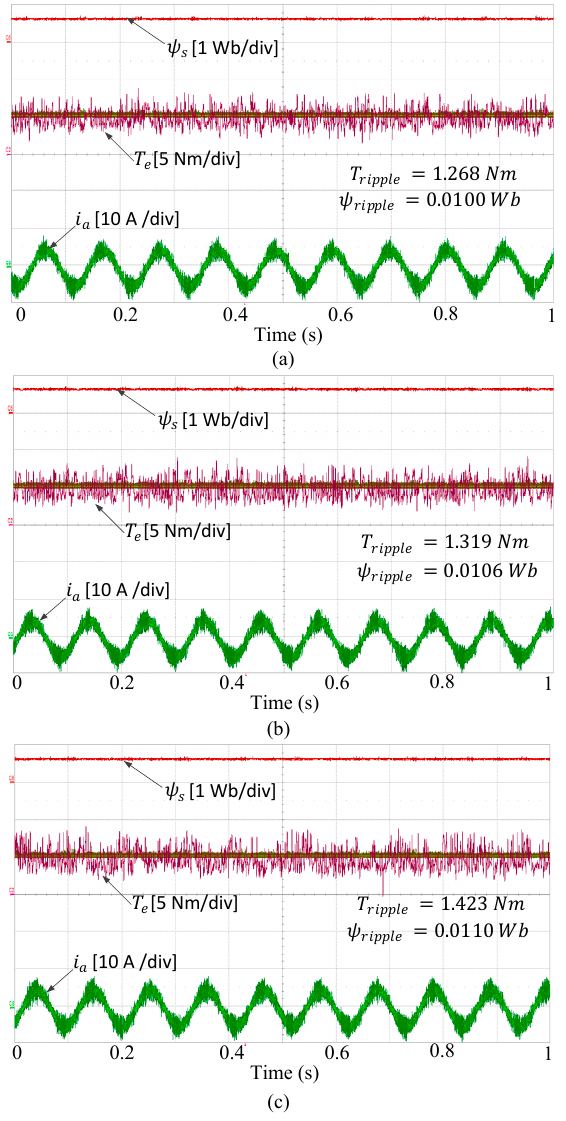
Figure 11. Experimental results of steady-state performance for ( a ) interleaving CFTR-3, ( b ) interleaving CFTR-4, and ( c ) interleaving